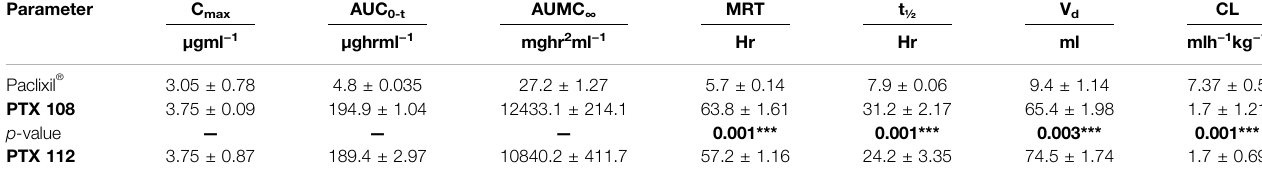
TABLE 7 | Pharmacokinetic parameters. The p -values are made bold as it shows the signi fi cance of results.